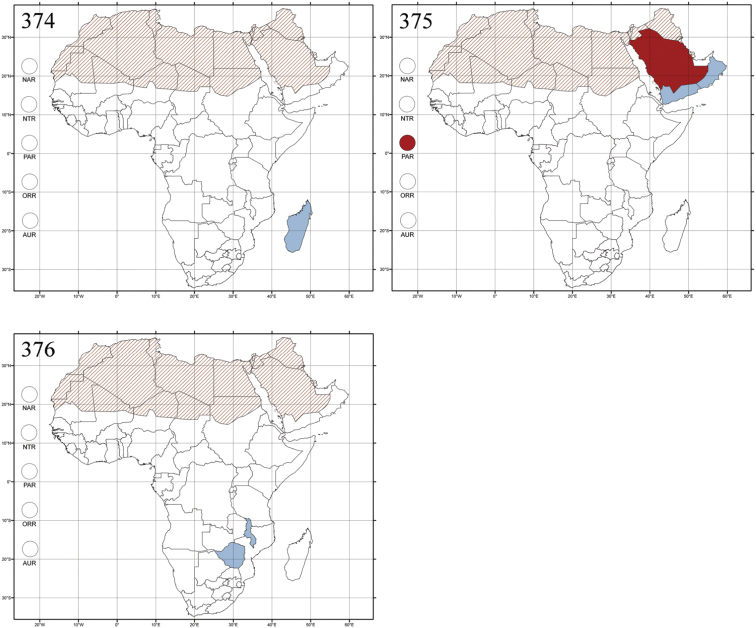
Maps of distribution. 374
Xanthophysca Fairmaire 375
Yemenaltica Scherer 376 Zomba Bryant.